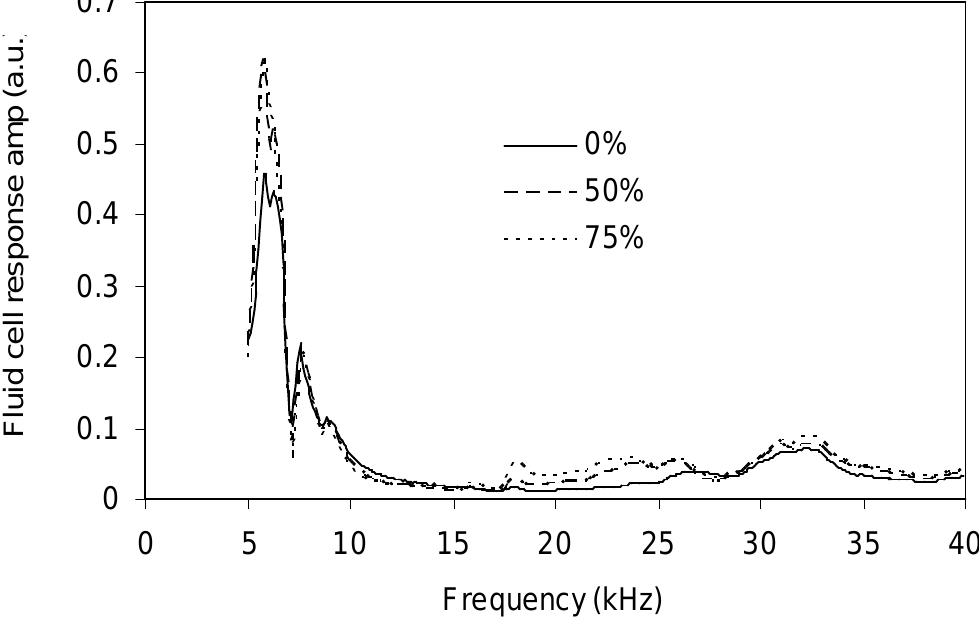
Figure 8. Fluid cell frequency responses when containing solutions of glycerin and water, observed with cantilever